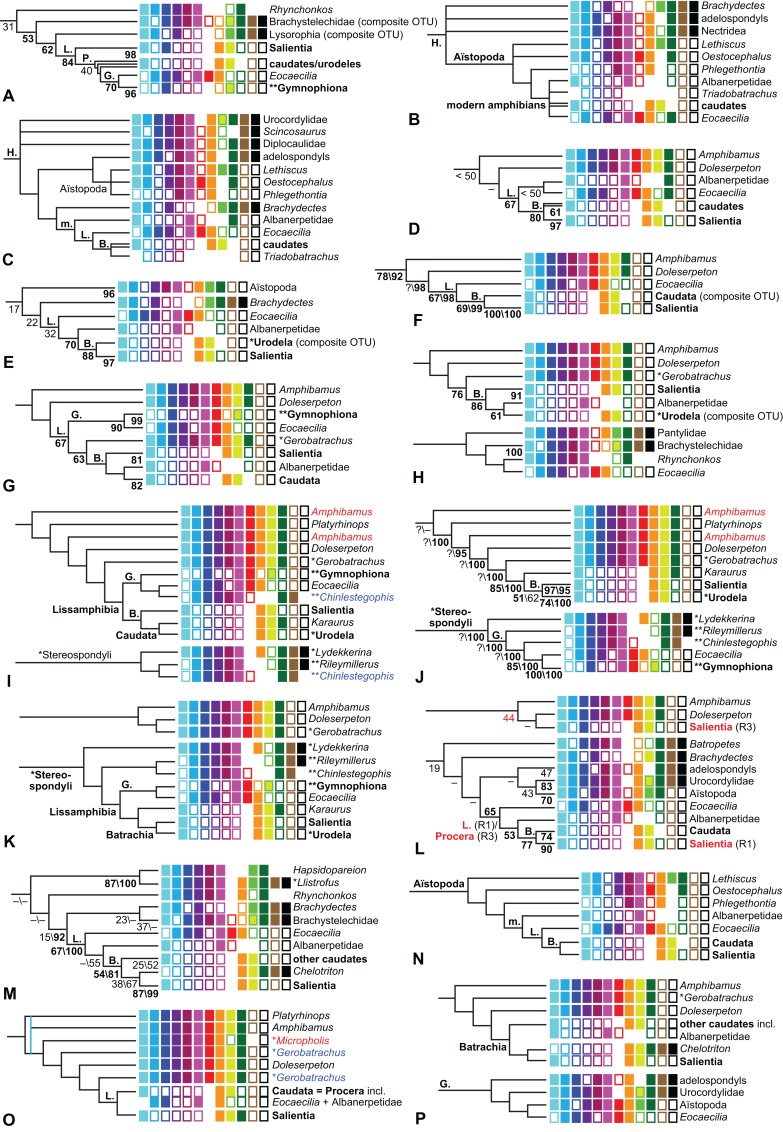
The phylogeny of modern amphibians and their closest relatives in recently published (A–K) and our (L–P) analyses, and the distribution of several character states.Albanerpetidae is a composite OTU throughout. Numbers in (A), (D), (E), (G), (H) are bootstrap percentages. B., Batrachia; G., Gymnophionomorpha (not shown when Eocaecilia is the only included member); L., Lissamphibia; m., modern amphibians (when not synonymous with L.); P., Procera. (A) Vallin & Laurin (2004); the two unnumbered “caudate” nodes have bootstrap values below 30%. (B) Pawley (2006: fig. 88; see Fig. 28B). (C) Pawley (2006: fig. 91; see Fig. 28C). (D) RC07. We write “< 50” where RC07 (app. 4) wrote “no bootstrap support in a 50% majority-rule consensus” and “–” where they wrote “no boots[t]rap support compatible with a 50% majority-rule consensus”. Caudate monophyly was found in some MPTs and, as shown here, 61% of the bootstrap replicates. (E) Marjanović & Laurin (2009). (F) Sigurdsen & Green (2011: fig. 2B, 4). Numbers are bootstrap percentages from unweighted parsimony (left; not published if below 50) and Bayesian posterior probabilities (right; in %). (G) Maddin, Jenkins & Anderson (2012). Bootstrap percentages below 50 were not published. (H) Huttenlocker et al. (2013). Bootstrap percentages below 50 were not published. (I–K) MPTs from Pardo, Small & Huttenlocker (2017); see Marjanović & Laurin (2018). Numbers in (J) are bootstrap percentages (left; not published if below 50) and Bayesian posterior probabilities (right; in %). The ribs of **Rileymillerus are scored under the assumption that the tentatively referred postcrania really belong to a juvenile of the same taxon as the holotype, which is a skull (Bolt & Chatterjee, 2000); this is at least not contradicted by the postcrania of **Chinlestegophis (Pardo, Small & Huttenlocker, 2017). (L) R1 (unconstrained), R3 (constrained for the PH; both original taxon sample). Numbers are BPO given that Salientia has the position it has in R1. (M) R4 (unconstrained, expanded taxon sample). Numbers are BPE\PP. (N) R2 (constrained against the LH, original taxon sample). (O) R5 (constrained against the LH, expanded taxon sample); Micropholis also has two positions outside the clade shown here. (P) R6 (constrained for the PH, expanded taxon sample). Except where mentioned otherwise below, the rectangles show state 0 (filled) or 1 (empty) of characters 18 (LAC 1—cyan), 39 (POSPAR 1–2—teal), 45 (POSFRO 1—blue), 53 (TAB 1/SQU 4—violet), 60 (POSORB 1—reddish purple), 71 (JUG 1—magenta), 72 (JUG 2–6—red), 77 (QUAJUG 1—orange), 102 (VOM 1–13—bright green and greenish yellow, see below), 160 (ANG 1—dark green), 246 (RIB 3—brown) and 250 (RIB 7—black). Absence of a rectangle means missing data, inapplicability or ambiguous optimization at the root of a collapsed clade, except that *Lydekkerina is polymorphic for character 72. State 1 of the unordered character 39 does not occur in this figure, so empty rectangles show state 2. State 2 of the ordered character 72 is limited to Pantylidae in this figure and therefore shown as state 1. The ordered character 102 has three states: vomer about as wide as long or wider (0, filled greenish yellow rectangles); intermediate (1, empty bright green rectangles); at least 2½ times as long as wide (2, filled bright green rectangles). Rectangles with a bright green rim filled in with greenish yellow indicate ambiguous optimization of state 1 or 2. Character 18: presence (0) or absence (1) of lacrimal; 39: presence (0) or absence (2) of postparietals; 45: presence (0) or absence (1) of postfrontal; 53: presence (0) or absence (1) of tabular; 60: presence (0) or absence (1) of postorbital; 71: presence (0) or absence (1) of jugal; 72: contact between maxilla and quadratojugal at ventrolateral edge of skull (0), jugal separates maxilla and quadratojugal and forms part of ventrolateral edge of skull (1 and 2); 77: presence (0) or absence (1) of quadratojugal; 102: see above; 160: presence (0) or absence (1) of angular; 246: ribs mostly straight (0, empty rectangles) or ventrally curved in at least part of the trunk (1, filled rectangles); 250: trunk ribs longer (0) or shorter (1) than three successive articulated vertebrae in adults. Note that we do not distinguish absence due to loss of an ossification center from absence as a separate bone due to ontogenetic fusion; in more or less all cases the ontogeny is insufficiently well known to decide. For further derivations within Caudata and Salientia, see the text. Adelospondylus has state 60(1), Notobatrachus is polymorphic for 77. The optimizations for character 72 differ for Aïstopoda between (P) and the rest due to the larger taxon sample in (P); likewise, the optimizations for character 160 vary for Caudata/Urodela depending on taxon samples.